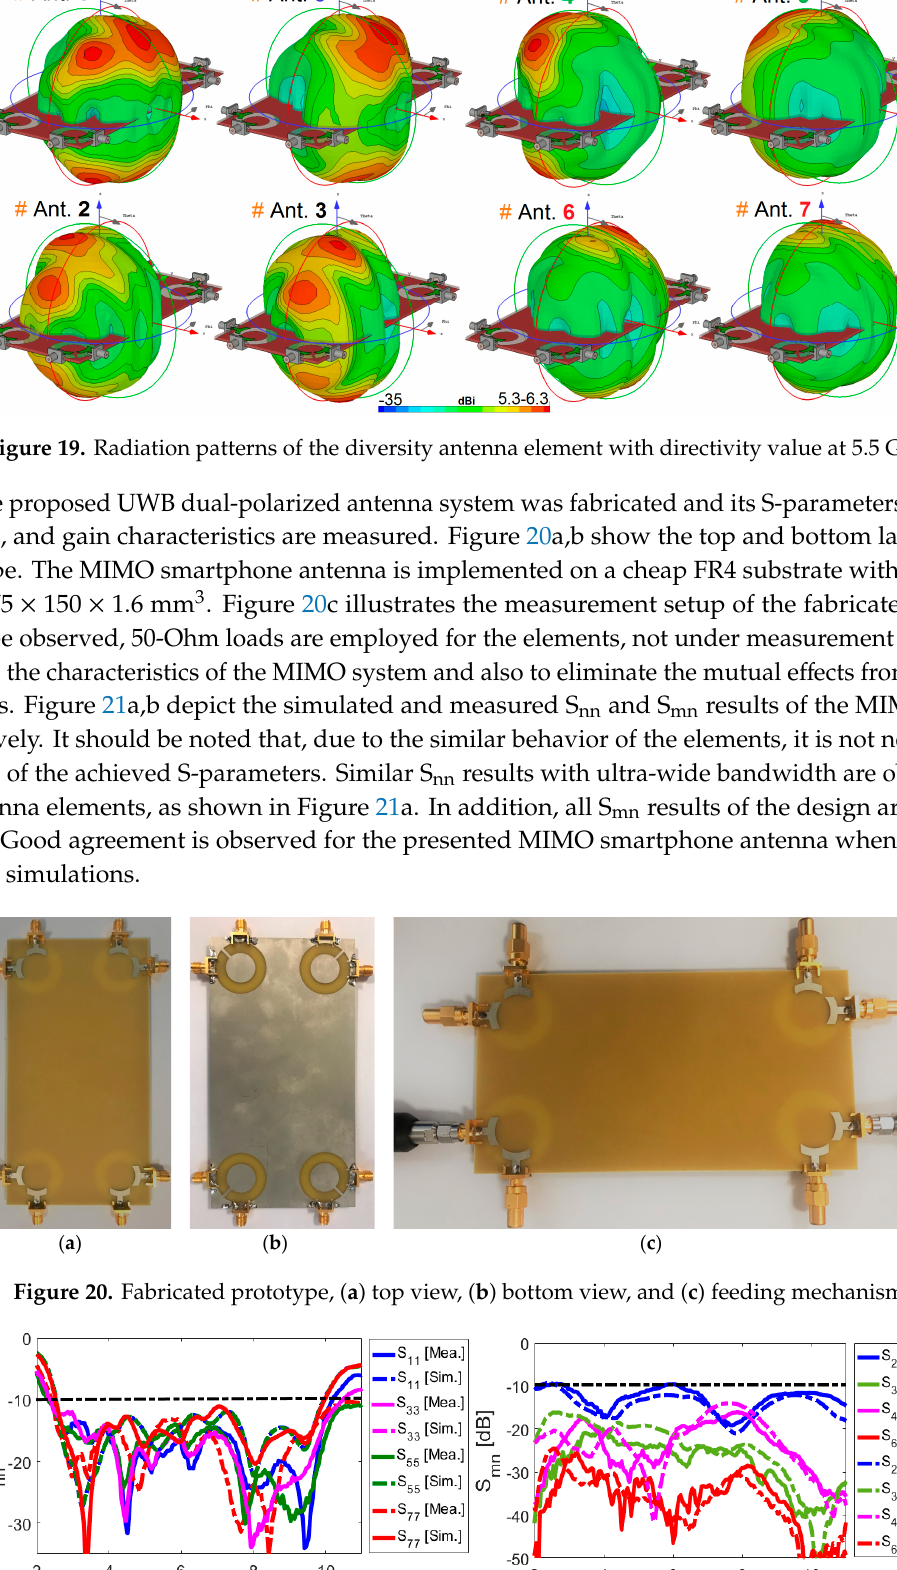
Figure 18. Efficiencies of the MIMO design.